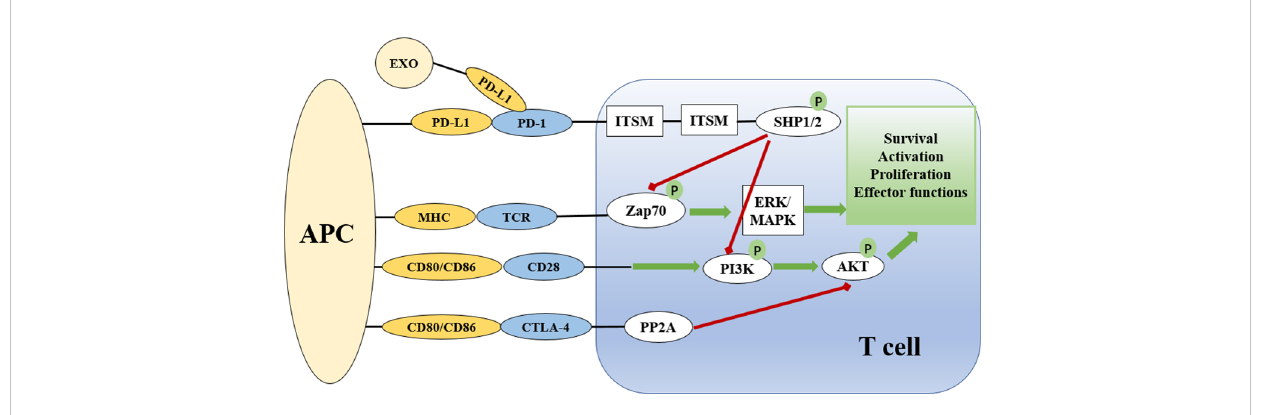
FIGURE 1 Overview of the PD-1 and PD-L1 checkpoints and signaling pathways associated with them. The presentation of antigen by MHC on APCs to the TCR complex on T cells activates T cells via the Zap70 and ERK/MAPK signaling pathways. CD28 on T cells binds to CD80/86 on APCs to provide co-stimulatory signals. PD-1/PD-L and CTLA-4 signaling suppress the AKT signaling pathway to limit T cell activation. CTLA-4 suppresses the AKT pathway directly by recruiting PP2A, while PD-1 signaling includes SHP-mediated regulation of Zap20 and the PI3K/AKT signaling pathway. Green lines indicate stimulatory messages, while red lines represent inhibitory ones. ITSM and ITIM are intracellular domains of immunological checkpoints that are responsible for intracellular signaling. APC, antigen presenting cell; TCR, T cell receptor; MHC, major histocompatibility complex; PD-1, programmed death-1; CTLA4, cytotoxic T lymphocyte antigen-4; ZAP70, zeta chain of T cell receptor associated protein kinase 70; PI3K, phosphoinositide 3 kinase; PP2A, protein phosphatase 2A; ERK, extracellular signal-regulated kinase; MAPK, mitogen activated protein kinase; AKT, protein kinase B; ITIM, immunoreceptor tyrosine-based inhibition motif; ITSM, immunoreceptor tyrosine-based motif; SHP, Src homology region 2 domain-containing